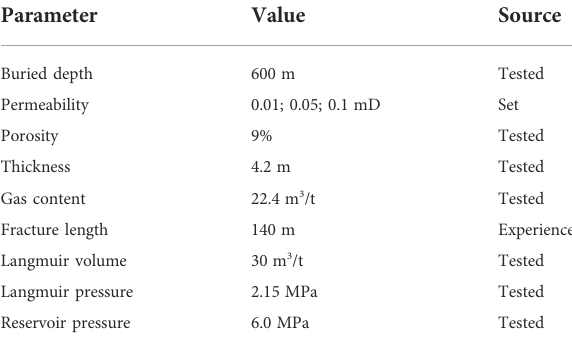
TABLE 3 Reservoir parameters for well ZD01.